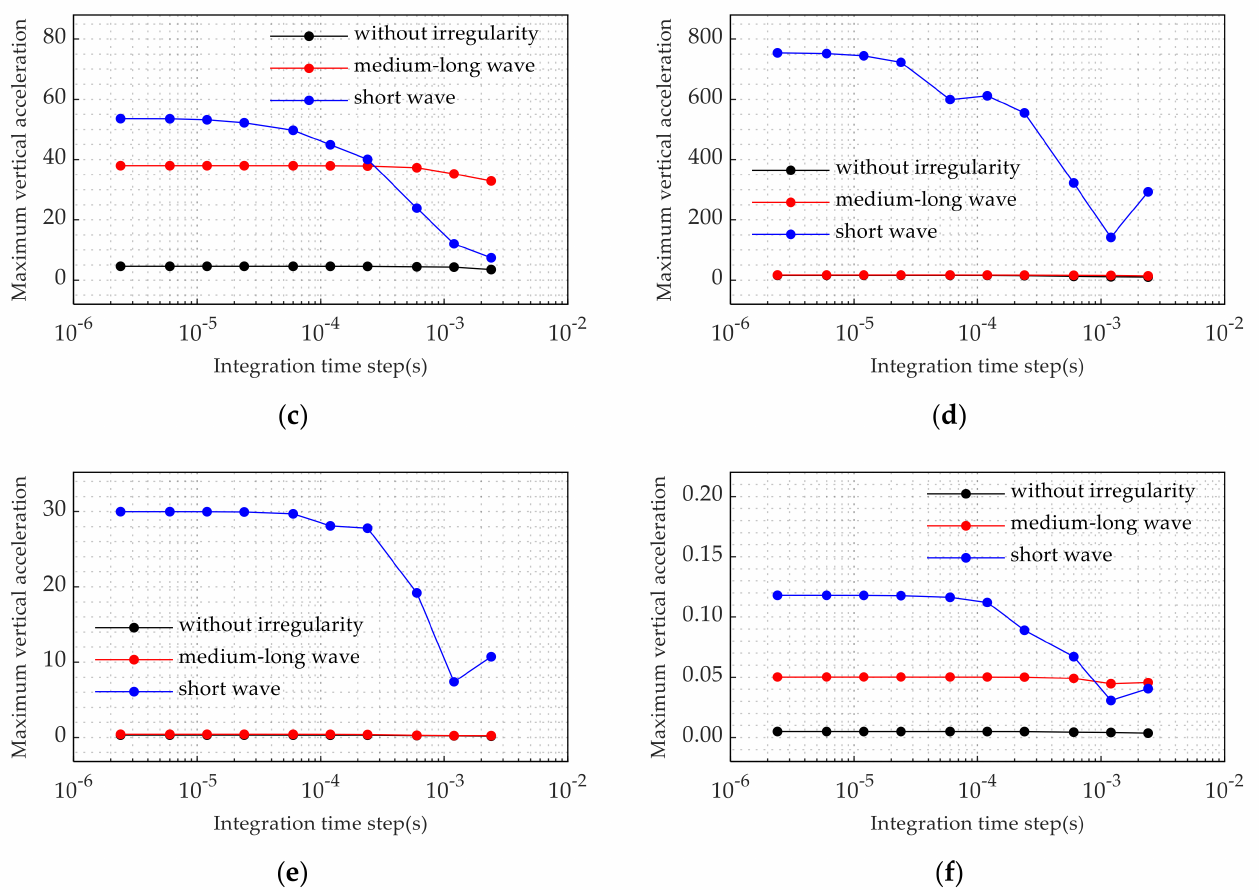
Figure 13. The effect of the integration time step on the maximum vertical acceleration of the: ( a ) car body; ( b ) bogie; ( c ) wheel-sets; ( d ) rail; ( e ) track slab; ( f ) bridge under different track irregularity